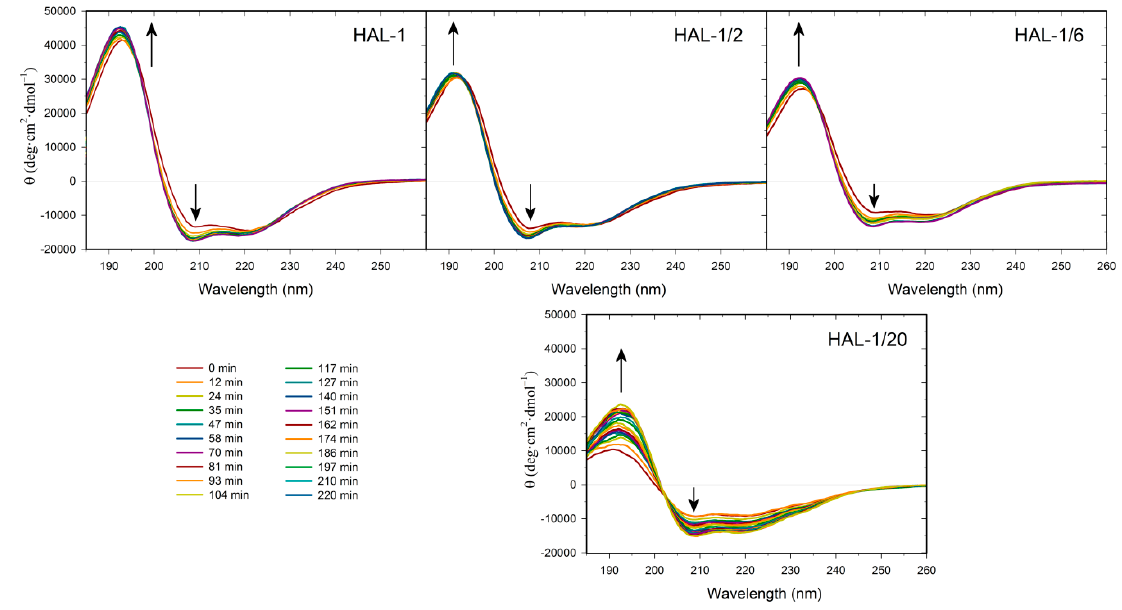
Figure 5. Time dependence of ECD spectra of HAL-1 and its analogs (0.125 mg/mL) in PC/PG = 1:4 mixtures (L/P = 20), measured within a 280-min time interval after the sample preparation with a 12-min step. The arrows show the direction of spectral changes with time.